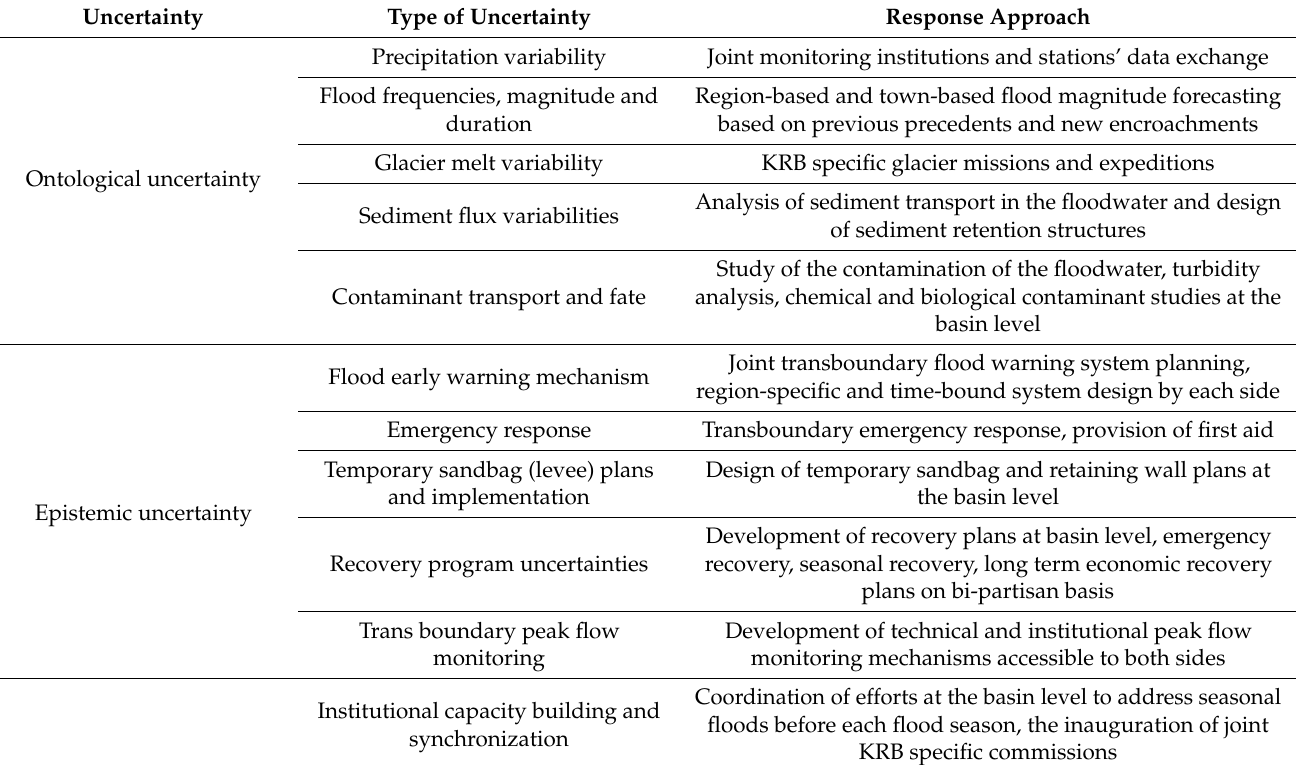
Table 4. Transboundary ontological and epistemic uncertainties related to flood prevention. Uncertainty Type of Uncertainty Precipitation variability Flood frequencies, magnitude and duration Ontological uncertainty